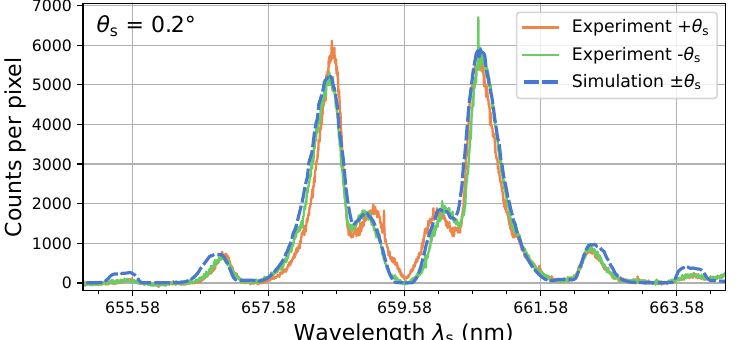
= 0.2 ◦ . s , thus only one s